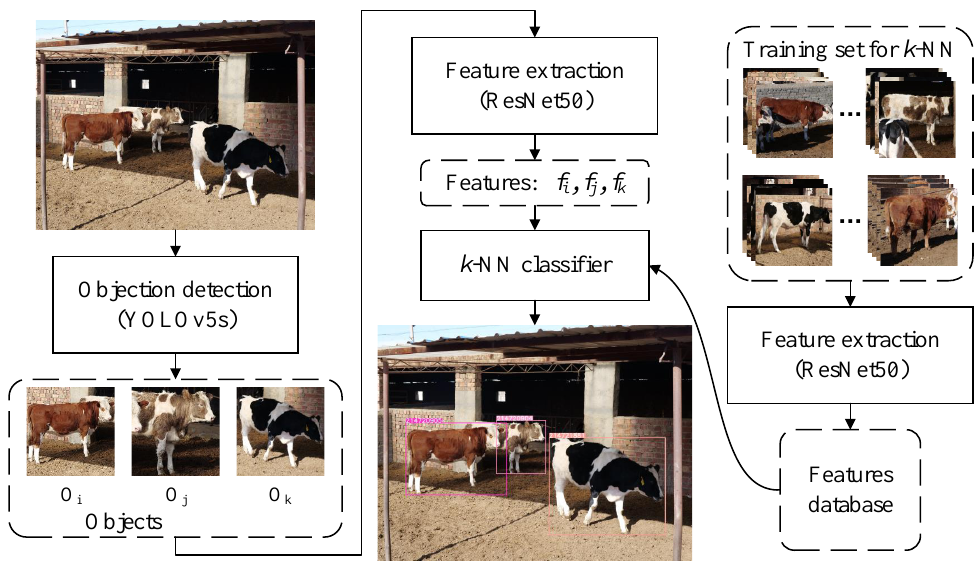
Figure 6. Engineering application pipeline. The images in the CNSID100 dataset were acquired partly by digital cameras, partly by smart phones, and partly by surveillance cameras at more than 12 mega pixels. Then, they were cropped with the cattle object in the center and resized to 500 × 500 pixels. In the engineering application, the image taken from the surveillance camera in the farm was input into YOLOv5s [30] to detect cattle targets. Then, the target regions were cropped, resized, and input into ResNet50 [28] to extract features for each instance. k -NN was used to classify the features for identification. Best viewed in color.